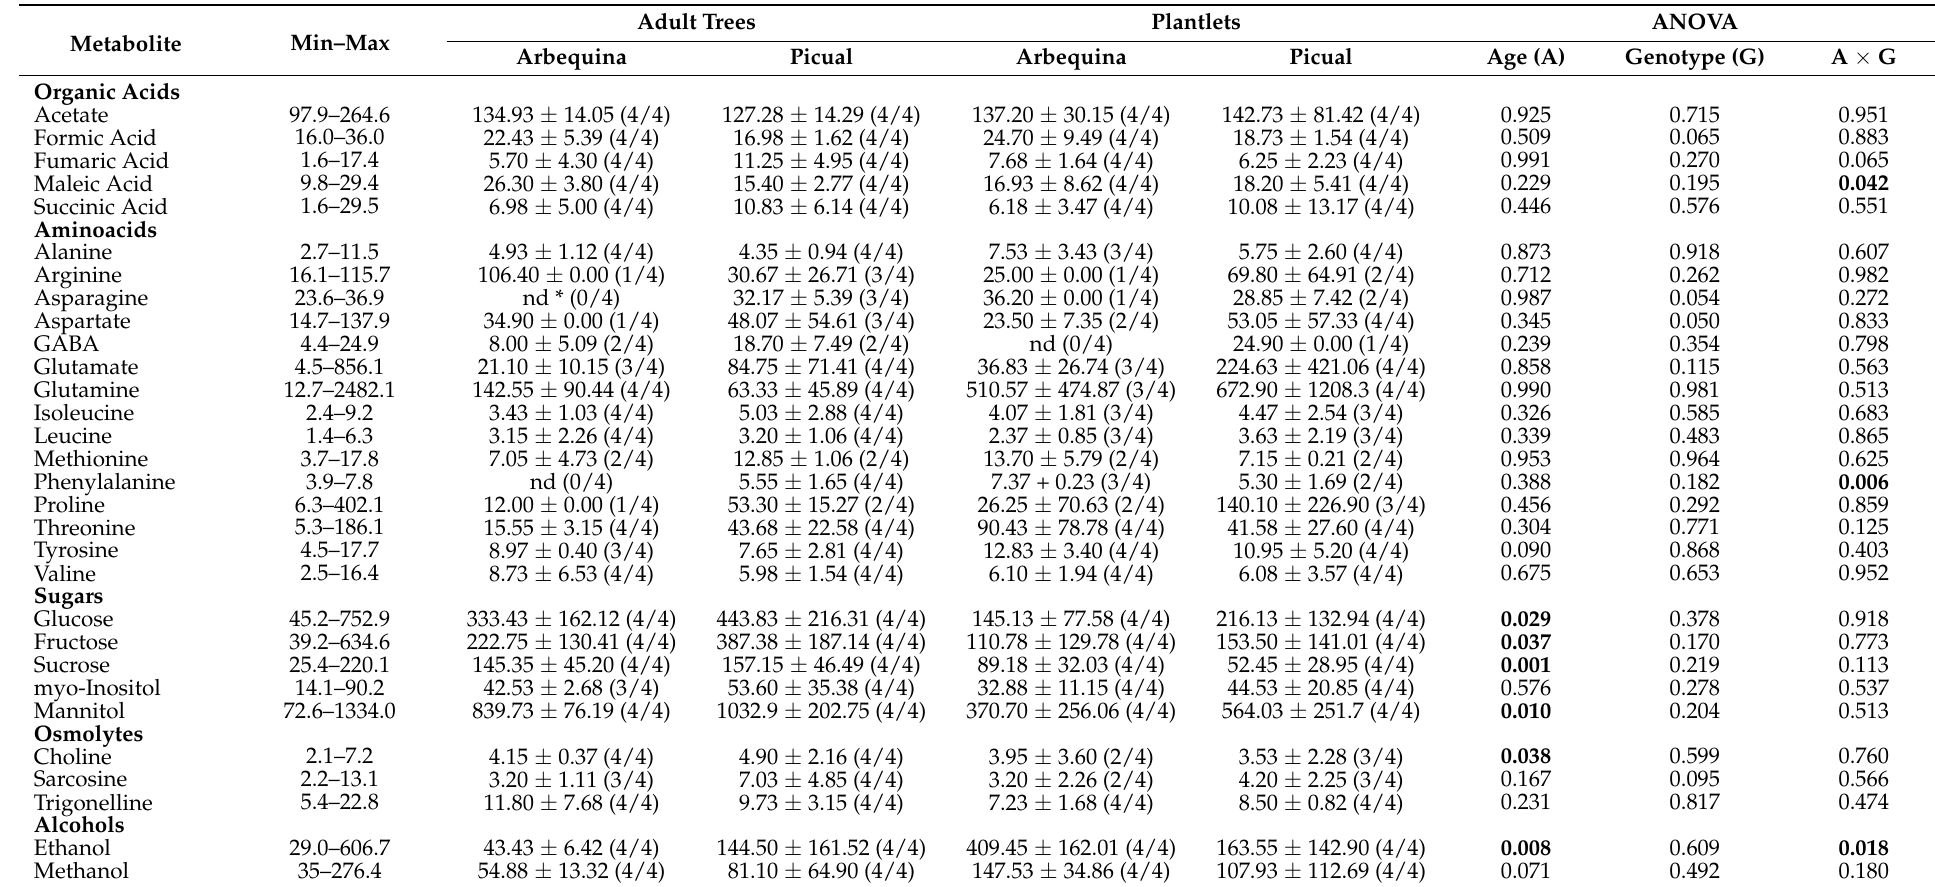
Table 1. Mean content ( µ M) and range of the main groups of metabolites identified in xylem sap from plantlets and adult olive trees of ‘Picual’ and ‘Arbequina’ genotypes and results of ANOVA analysis ( p -values of F test) to determine the effects of plant age, genotype and its interaction. For each treatment mean values and standard derivation are shown. Detection of each compound in the total samples tested is displayed in